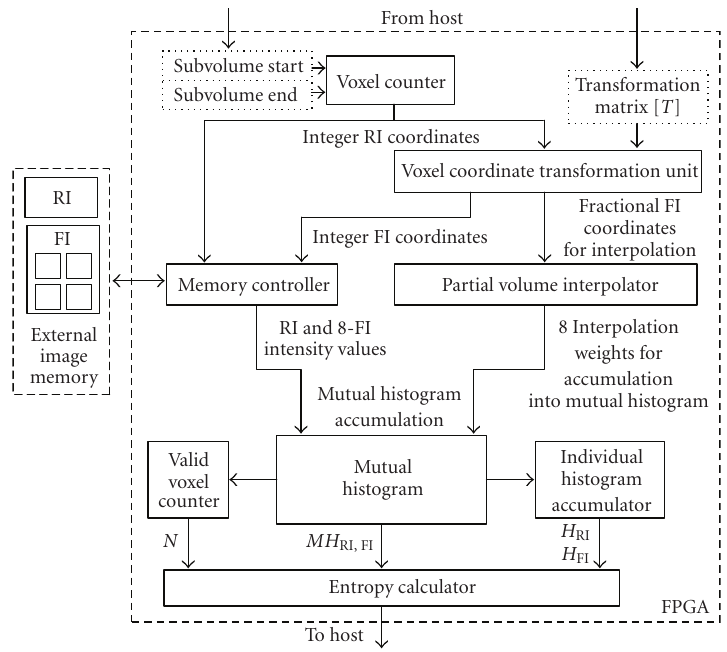
Figure 1: Top-level block diagram of FPGA-based architecture for MI